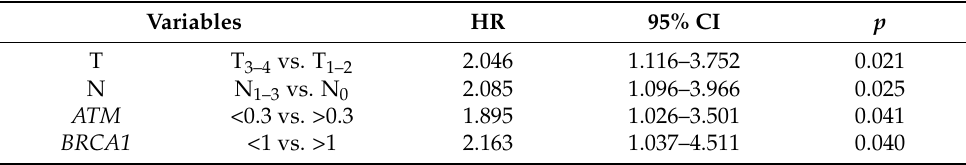
Table 4. Multivariate Cox model analysis of overall survival a